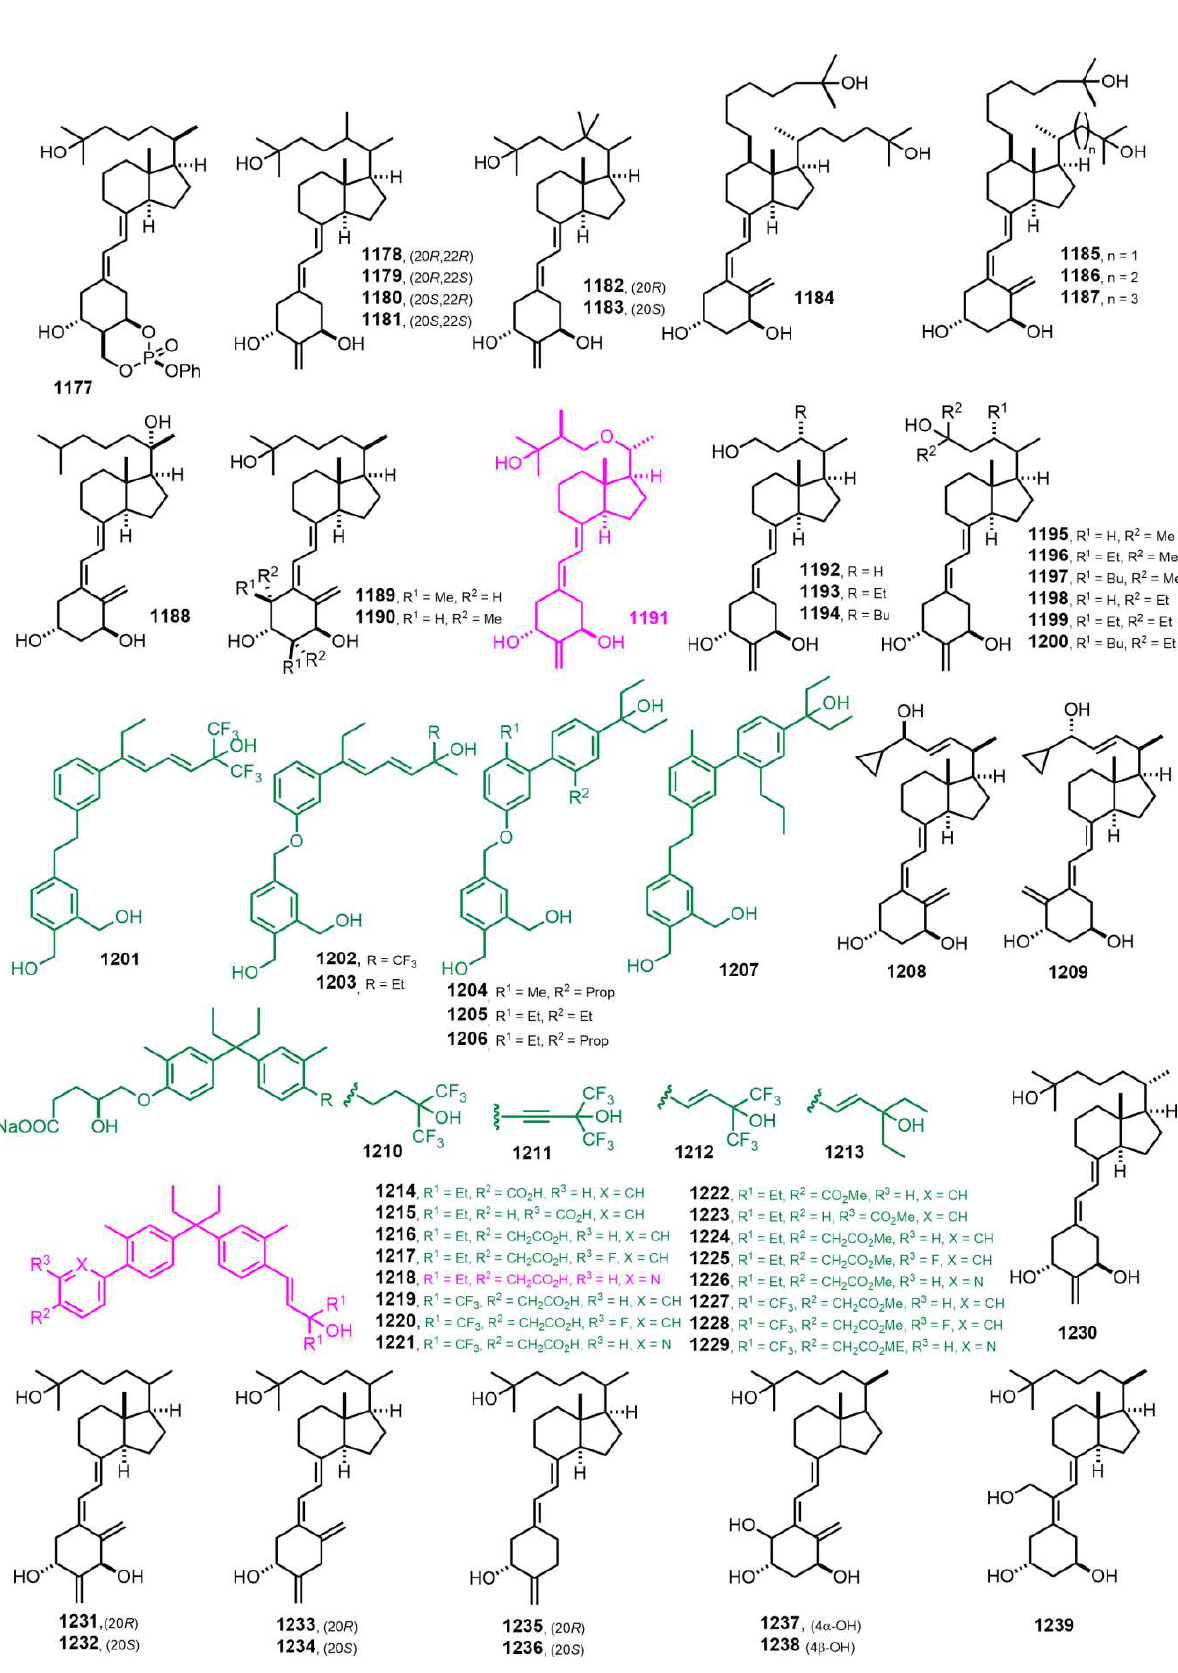
Figure 21. (2012–2013)